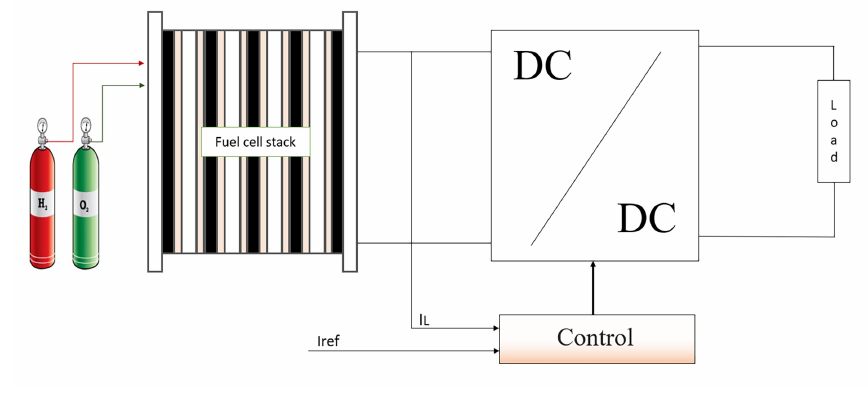
Figure 4. Closed-loop